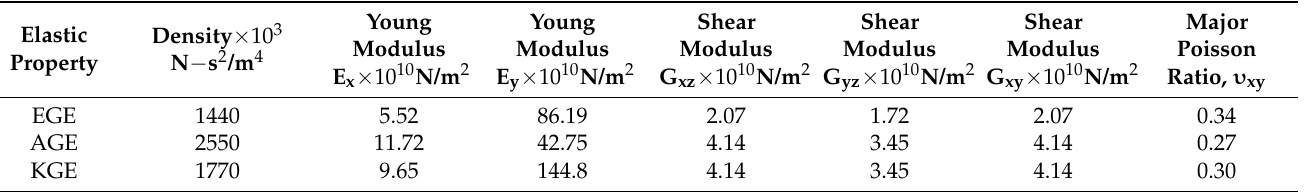
Table 6. Elastic properties of materials used.